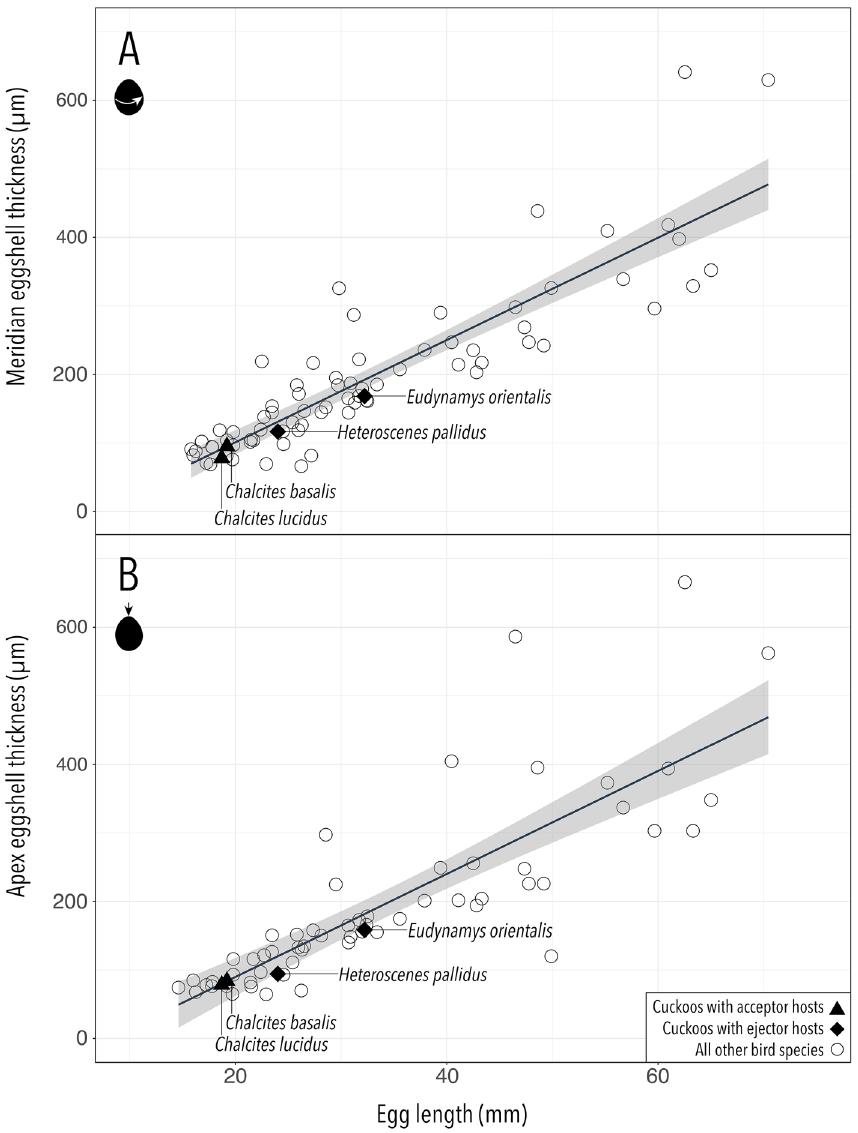
Figure 3. Eggshell thickness as a function of egg length in avian species. Eggshell thickness was measured at two points on the egg: ( A ) the meridian of the egg, which is the circumference around the widest part of the egg ( N = 73) and ( B ) the apex of the egg, which is the most conical end opposite the air sac ( N = 59). Linear regression was conducted on species that do not employ a brood parasitic reproductive strategy (circles). Brood parasitic cuckoos were plotted separately (filled black markers). Cuckoo species that parasitise acceptor hosts without egg ejection (black triangles) and cuckoo species that exploit egg-ejecting hosts (black diamonds) fell within the 95% confidence limit (grey shaded area) predicted for non-parasitic species. Figures of residuals when using phylogenetic correction are presented in supplementary material (Figs. S5 and